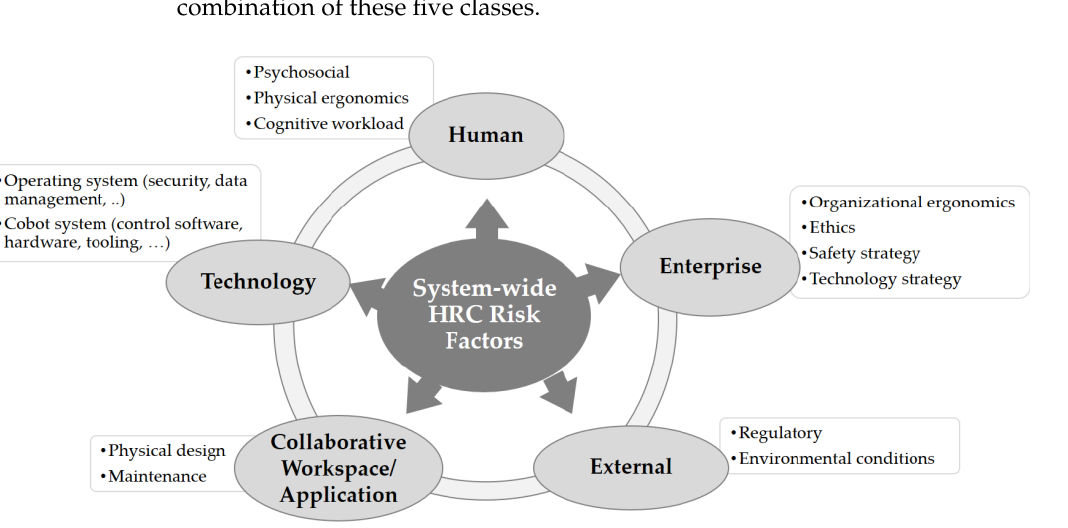
Figure 3. Risk factors classified in five classes and 13 sub-classes (based on Berx et al., 2022 [19]).